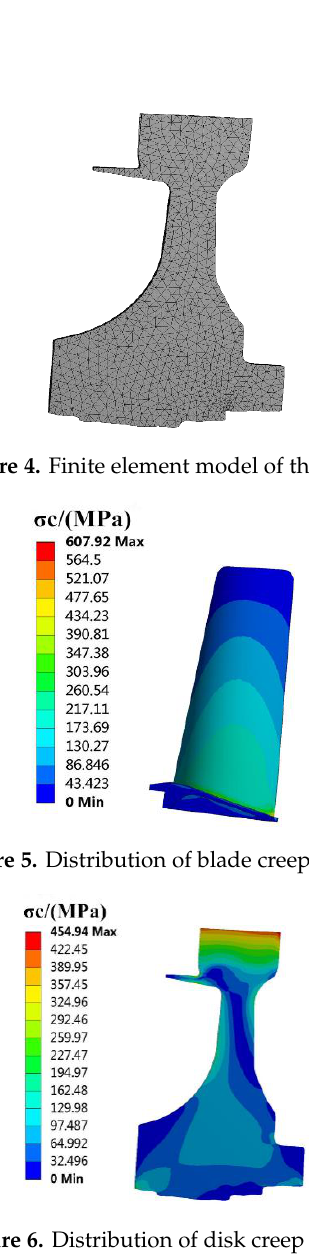
Figure 3. Finite element model of the blade.